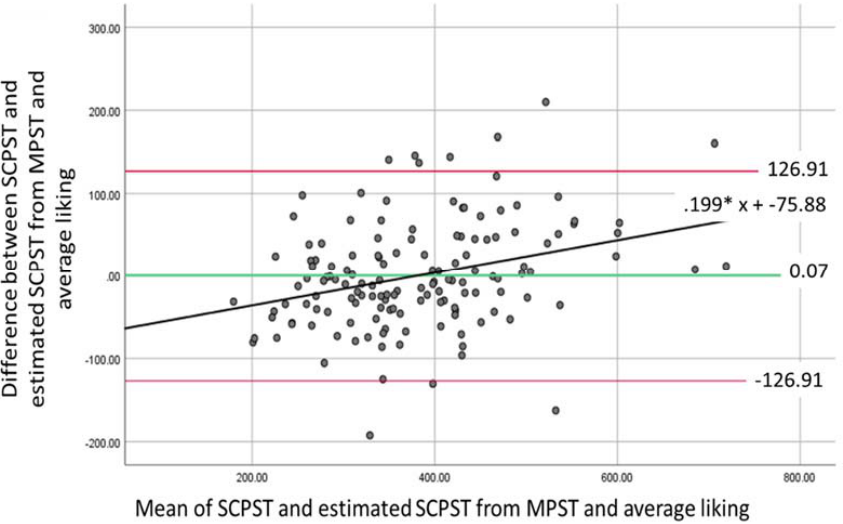
Figure 5. Bland–Altman plot for SCPST and SCPST estimate_MPST.